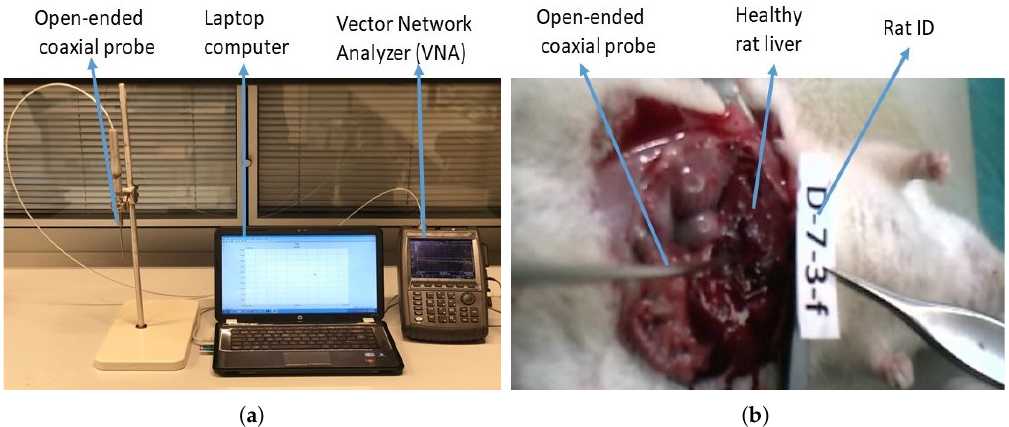
Figure 1. Dielectric property measurement setup: ( a ) measurement setup in a laboratory environment with Agilent Fieldfox N9923A Network Analyzer (NA), laptop computer, and integrated probe; ( b ) a picture taken during in vivo dielectric property measurements displaying the exposed liver of the experiment animal and the open-ended coaxial